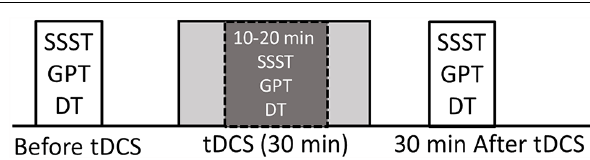
FIGURE 1 | Experimental design. Serial Seven Subtraction Task (SSST; count backward every 7th number as quickly as possible for 30 s). Grooved Pegboard Task (GPT; insert pegs into holes on the board one by one with the right hand, as quickly as possible for 30 s). Dual-Task (DT; perform both SSST and GPT for 30 s). All tasks (every single-task and dual-task) were performed before, during and 30 min after transcranial direct current stimulation (tDCS). Tasks performed during tDCS were performed 10 min after the onset of